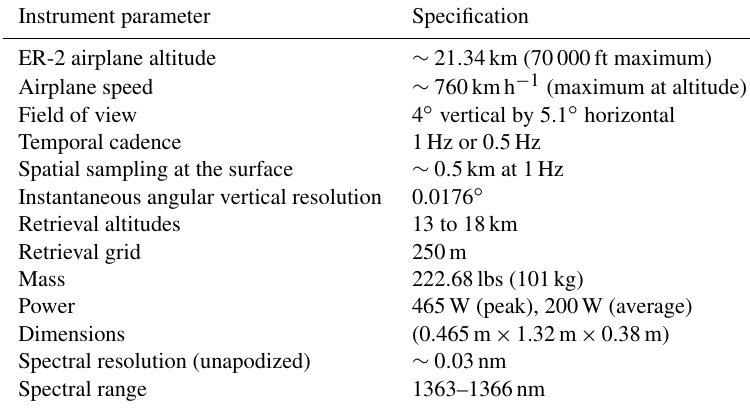
Table 1. SHOW ER-2 instrument parameters.